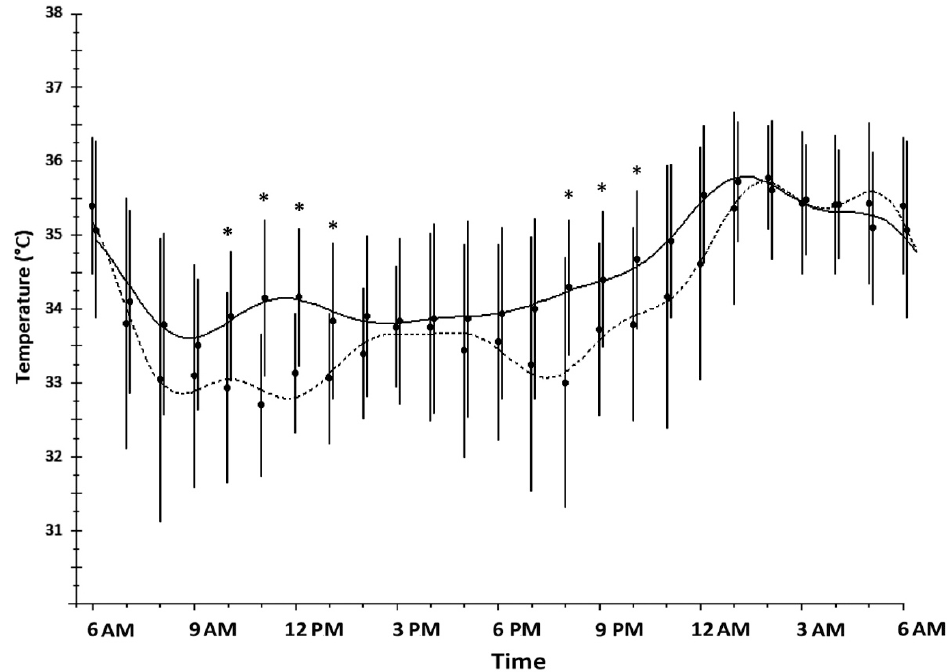
Figure 1. Profiles of wrist skin temperature of shift-working (solid line) and daytime (dashed line) nurses collected for a 24 h period. Data are expressed as the hourly mean ± SD. Statistical significance is indicated by * p < 0.05.